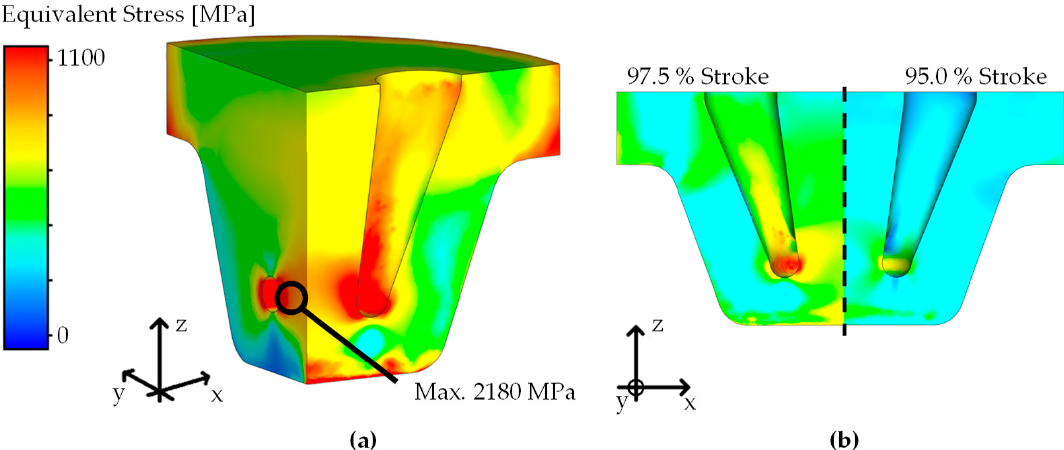
Figure 9. Equivalent stress at 100.0% stroke ( a ), at 97.5% stroke ( b ) and 95.0% stroke for Variant 03. The best parameter combination of the twelve models examined was found in Variant 10 (F = elliptic, Ø = 2.00/1.50 mm, S = 5.00 mm and R = 5.75 mm), shown in Figure